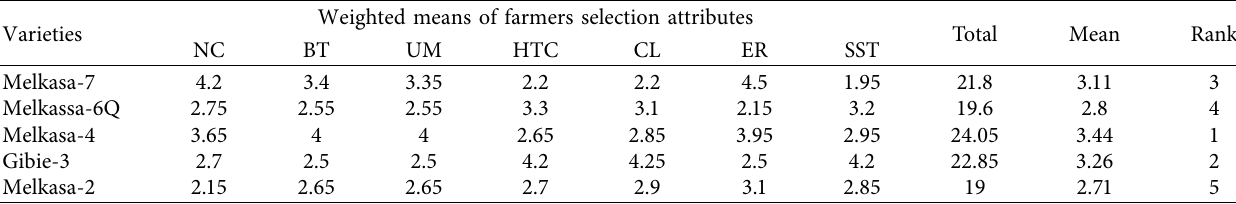
Table 7: A pair-wise ranking matrix of attributes for the selection of open-pollinated maize varieties in 2018. Attributes Cob Length Beer Tip Logging Tolerance Cob length Biomass Earliness Best ranked farmers’ selection attributes: earliness, bear tip, and lodging tolerance. Table 8: Farmers’ preference ranking matrix summary sheet for OPV maize varieties in 2017. Weighted means of farmers selection attributes Varieties Melkassa-6Q